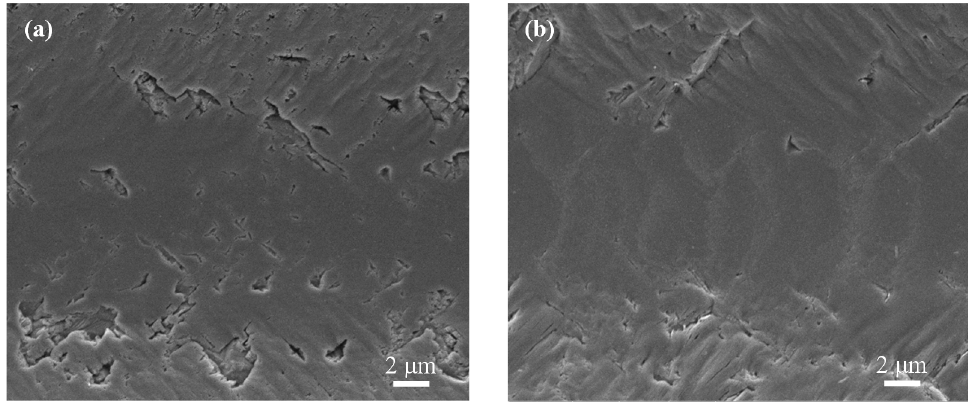
Figure 3. SEM images of the bottom of the groove formed by forward irradiation of ( a ) the HPHT sample and ( b ) the CVD sample at 10.3 J/cm 2 .